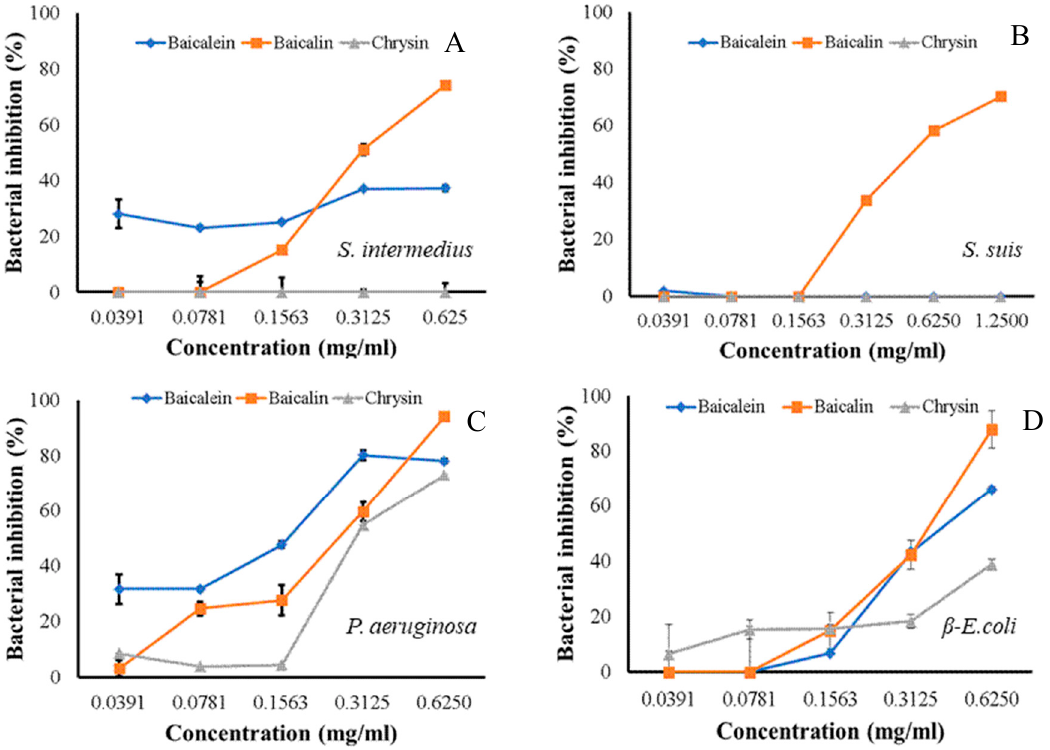
Figure 1. Dose-dependent manners of baicalein, baicalin, and chrysin inhibitory effects against four clinical isolated bacteria: Staphylococcus intermedius ( A ), Streptococcus suis ( B ), Pseudomonas aeruginosa ( C ), and β -Escherichia coli ( D ).